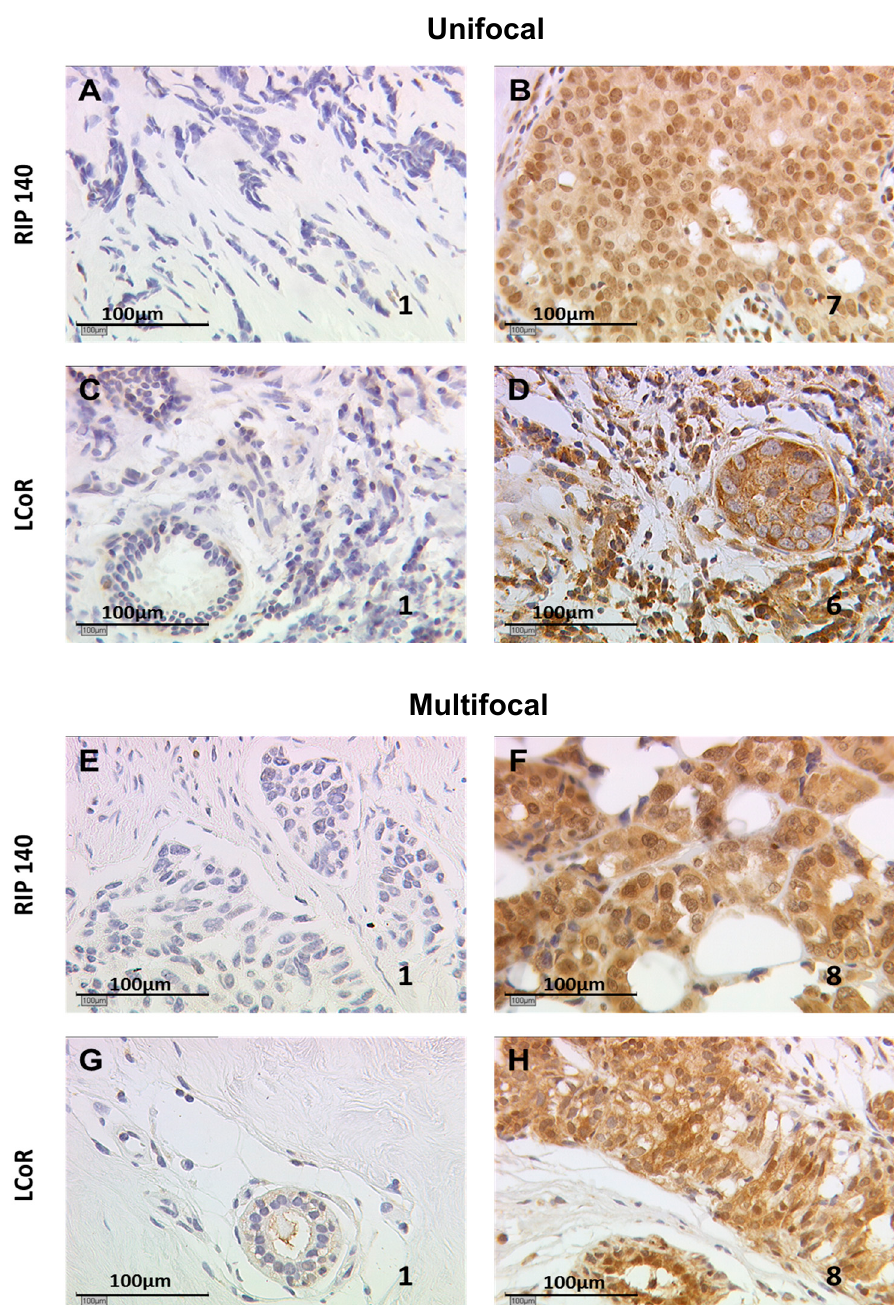
Figure 1. Immunohistological staining of receptor interacting protein of 140 kDa (RIP140) and ligand dependent corepressor (LCoR) in unifocal or multifocal breast cancers. RIP140 ( A , B , E , F ), and LCoR ( C , D , G , H ) expression was evaluated by immunohistochemistry in unifocal ( A – D ) and multifocal ( E – H ) cases. Positive staining appears in brown color, nuclei appear in blue. Examples of low expression ( A , C , E , G ) vs. high expression ( B , D , F , H ) have been selected (immunoreactive score (IRS) values indicated in each photograph).